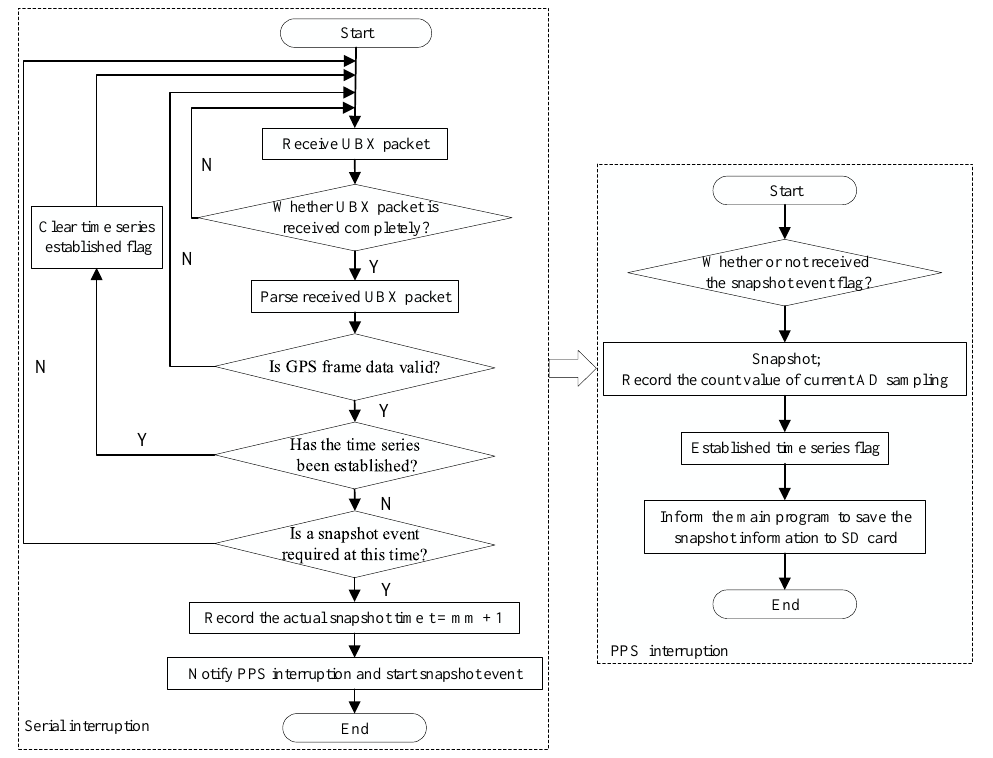
Figure 11. The flow diagram of the GPS serial interruption and PPS interruption.